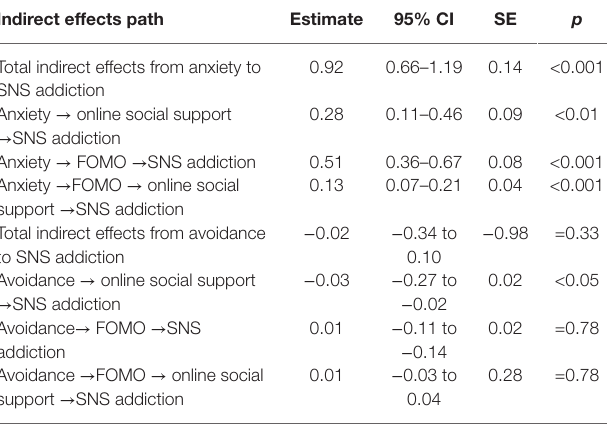
TABLE 2 | Indirect effect between insecure attachments and SNS addiction ( N =